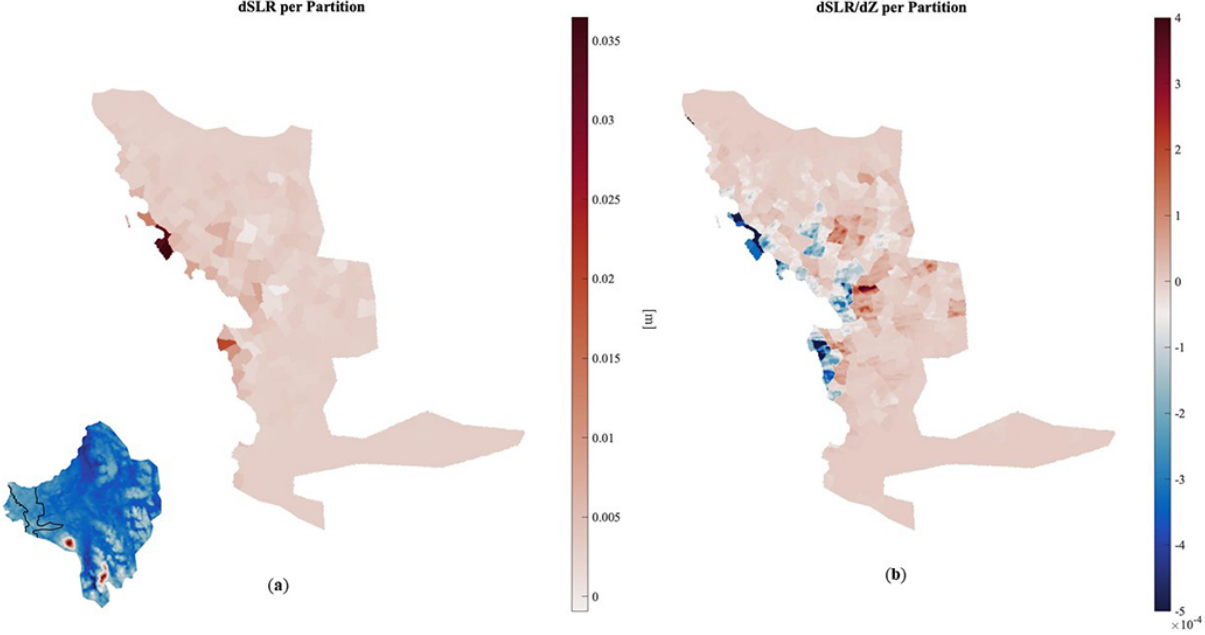
Figure 6. (a) A plot of the SLR change created by a partition’s independent perturbation. (b) A plot of the SLR change created by a partition’s independent perturbation is divided by the magnitude of the bedrock topography change for each mesh element. The quantity dSLR/dZ is